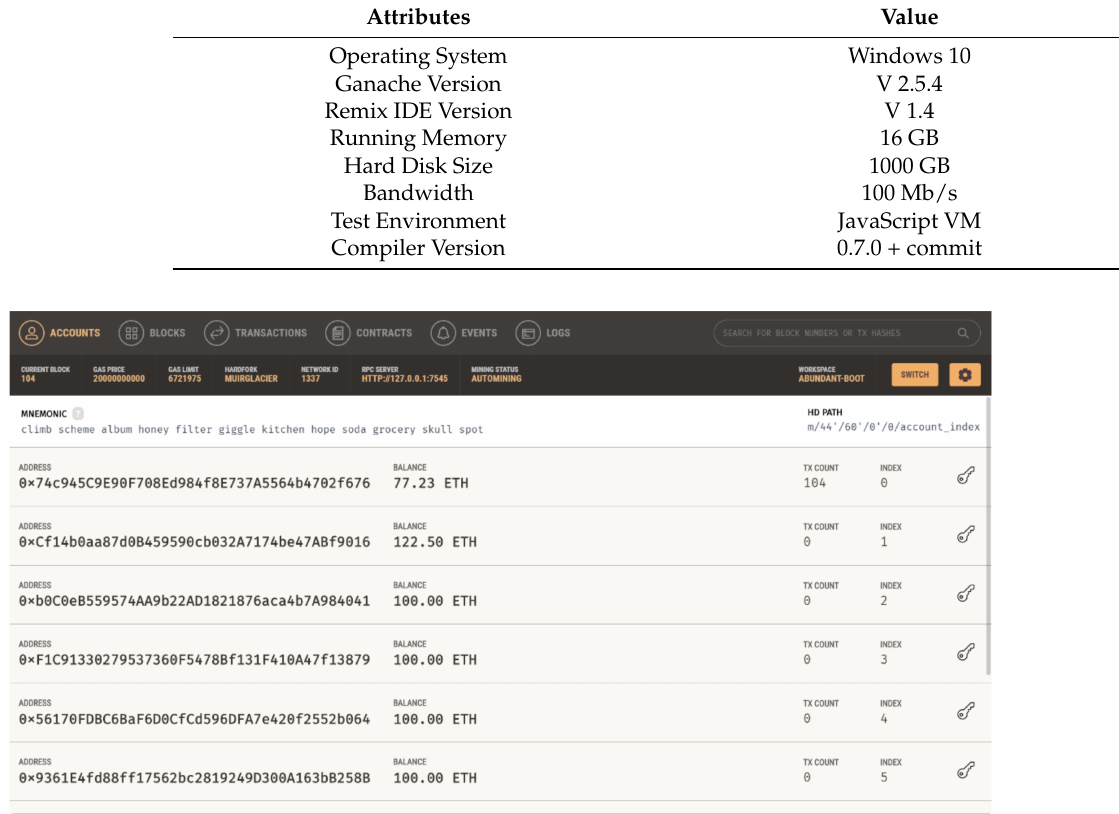
Figure 7. Ethereum account